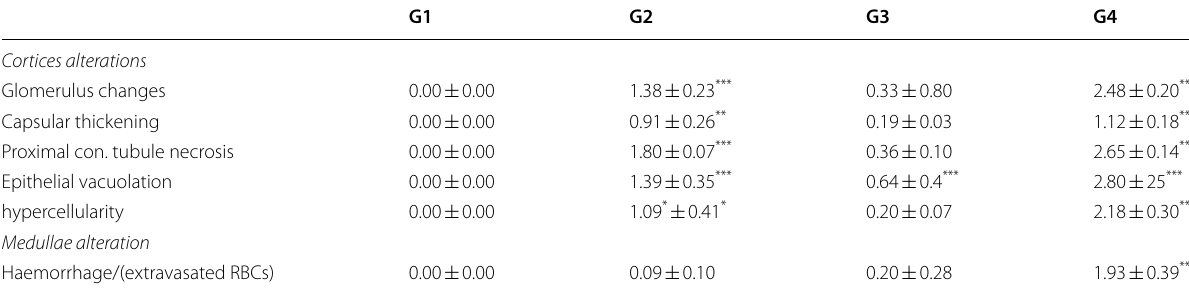
Data: mean SE., 0 no lesion; 1 mild effects; 2 moderate effects; 3 ± = = = G4: long‑term prophylactic design. P values: No